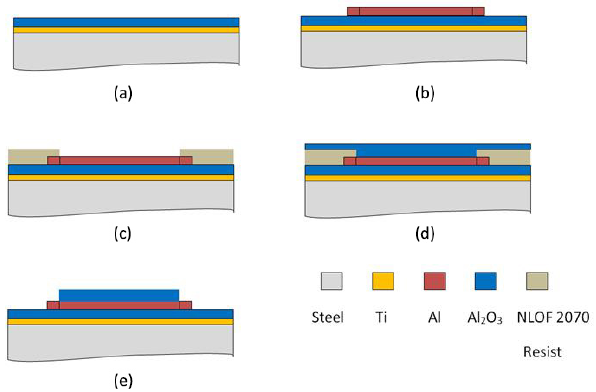
Figure 4. Steps for fabricating the sensor inlay: (a) sputter deposi- tion of a Ti layer as an adhesion promoter and deposition of the bot- tom isolation layer, (b) deposition, lithography, and chemical etch- ing of Al to form the resistive meanders and contact pads, (c) pho- tolithography with negative resist NLOF 2070 for covering the con- tact pads before deposition of top isolation, (d) deposition of the top isolation layer in a three-step process ( sputtering–evaporation– sputtering), and (e) lift-off of the underlying resist to structure the top isolation and open the contact pads for electrical connection.